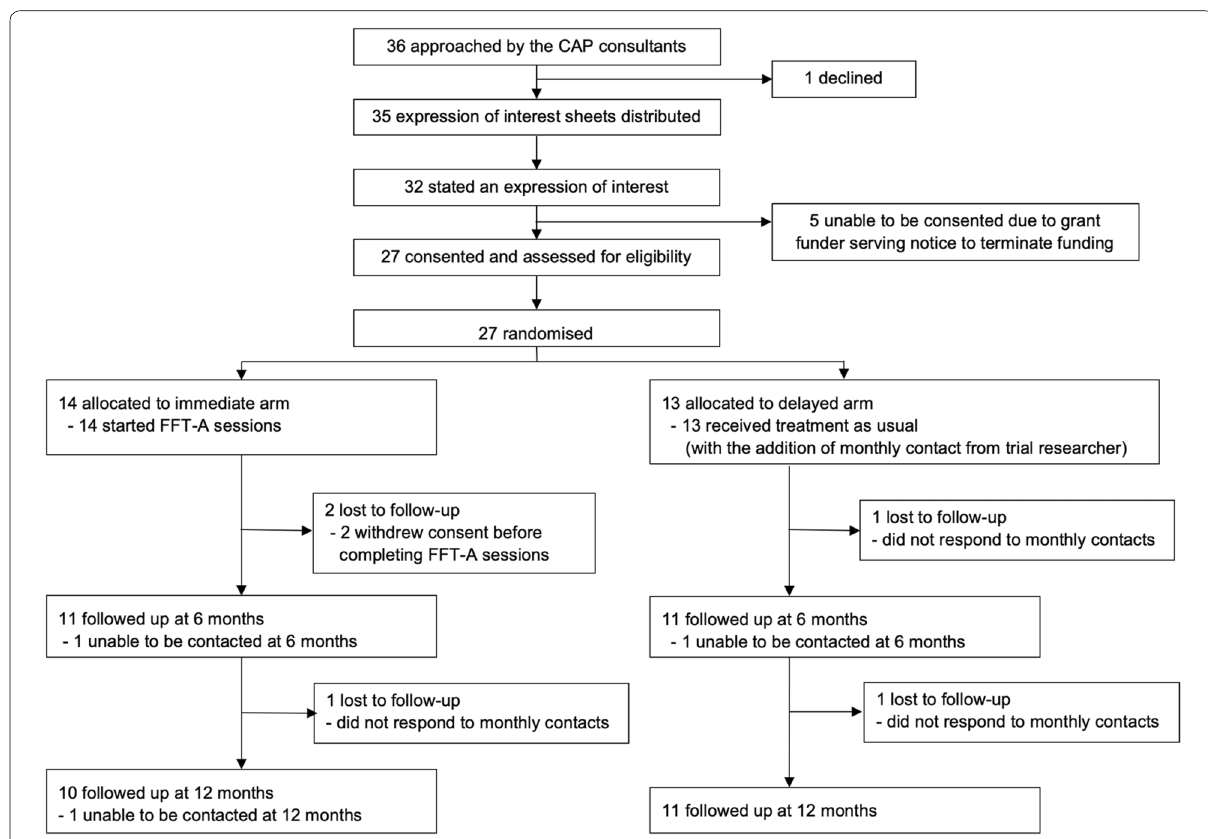
Fig. 1 CONSORT diagram. CAP-child and adolescent